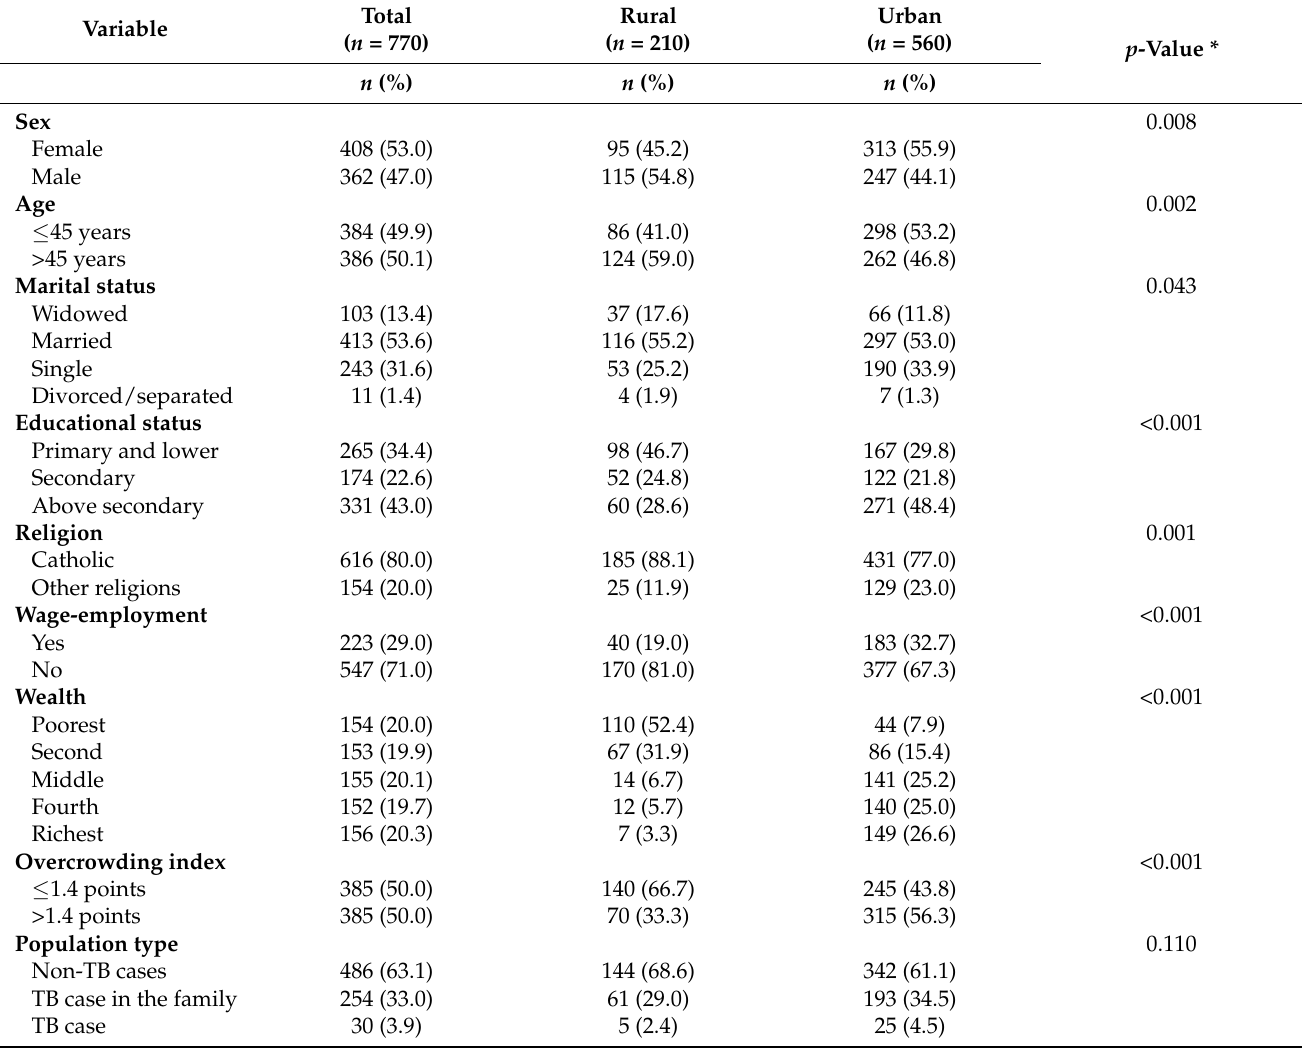
Table 1. Socio-demographic characteristics of the sample by